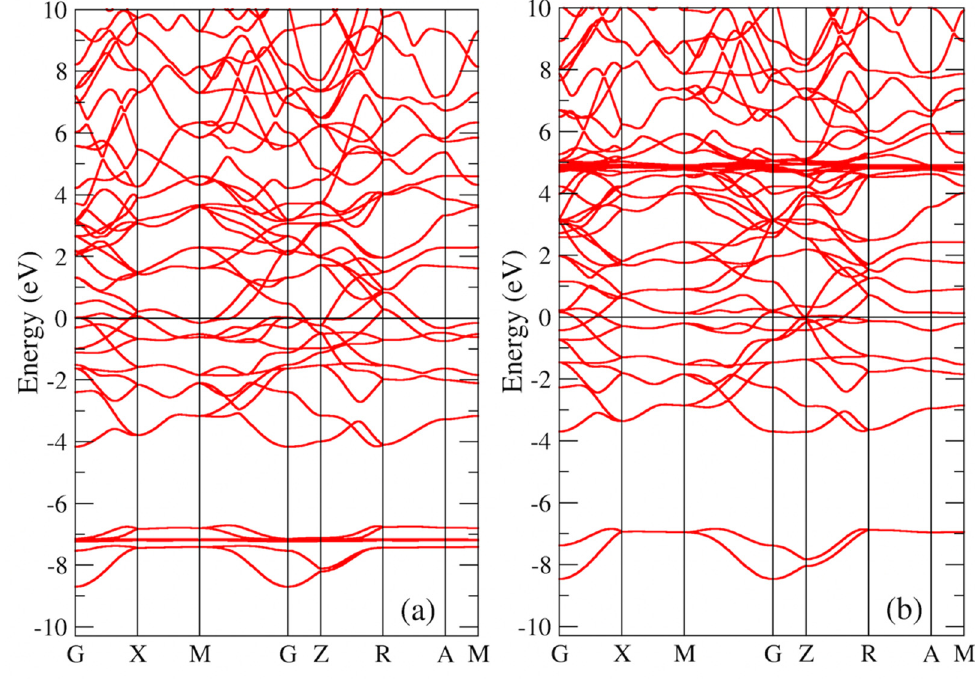
Figure 6. Band structure of GdTiSi. ( a ) Majority spin projection; ( b ) minority spin projection. The Fermi level is a solid horizontal line.